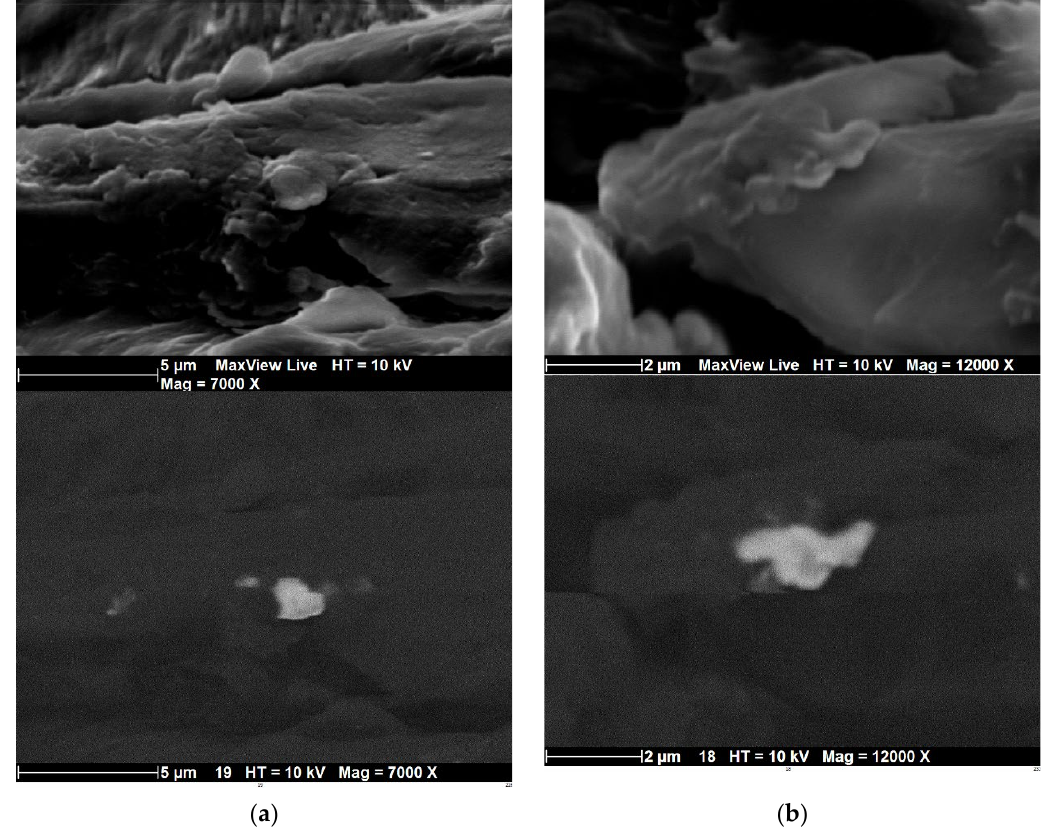
Figure 6. Zoomed-in views of a small area of a PLC filament cross-section showing the morphology of second phase particles using secondary electron imaging (top) and backscattered-electron imaging (bottom) modes with magnifications of ( a ) 7000× and ( b ) 12,000×.